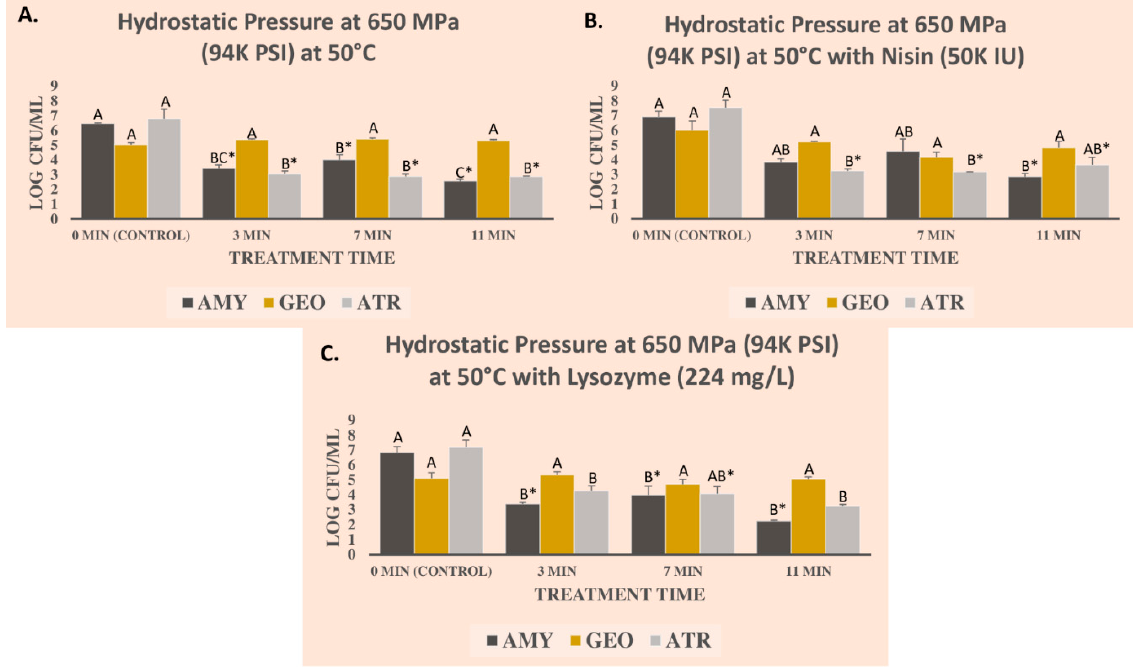
Figure 1. Inactivation of Bacillus amyloliquefaciens (AMY), Geobacillus stearothermophilus (GEO), and Bacillus atrophaeus (ATR) treated with the elevated hydrostatic pressure of 650 MPa at 50 °C in carrot juice. ( A. ) Treatments without any added antimicrobial. ( B. ) Treated with elevated hydrostatic pressure of 650 MPa at 50 °C with 50K IU ( w / v ) nisin. ( C. ) Treated with the elevated hydrostatic pressure of 650 MPa at 50 °C with 224 mg/L ( w / v ) lysozyme. For each panel of the figure and each bacterium separately, columns followed by different uppercase letters are statistically ( p < 0.05) different from each other (Tukey-adjusted ANOVA). Columns followed by * sign are statistically ( p < 0.05) different from the control (Dunnett’s-adjusted ANOVA).